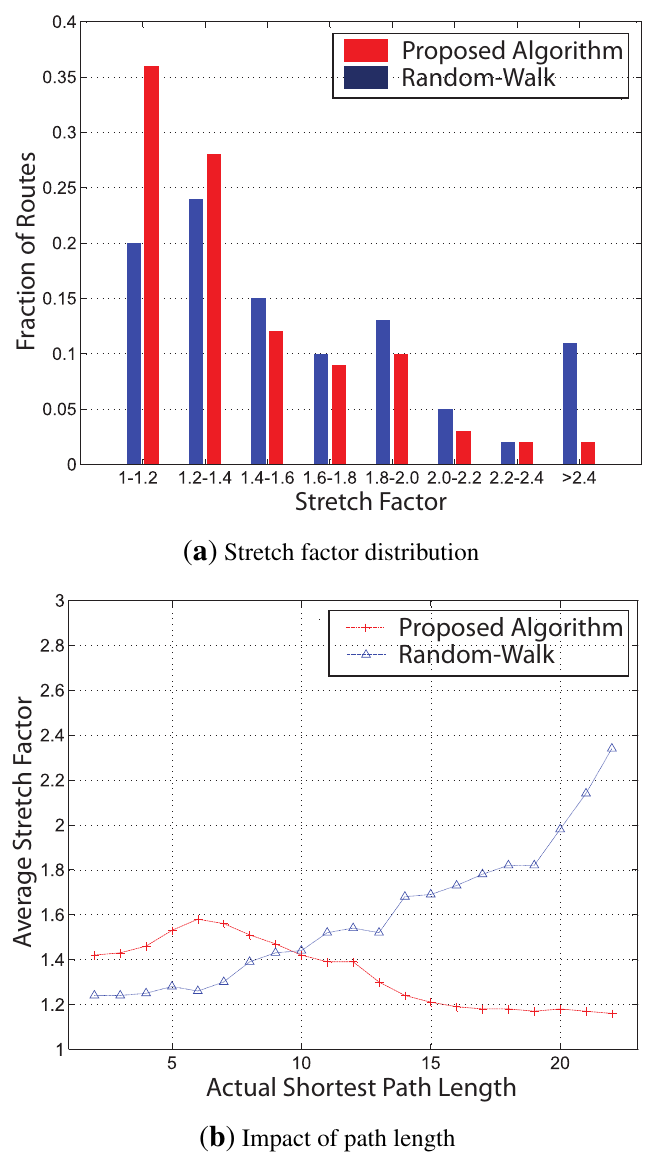
( b ) Impact of path